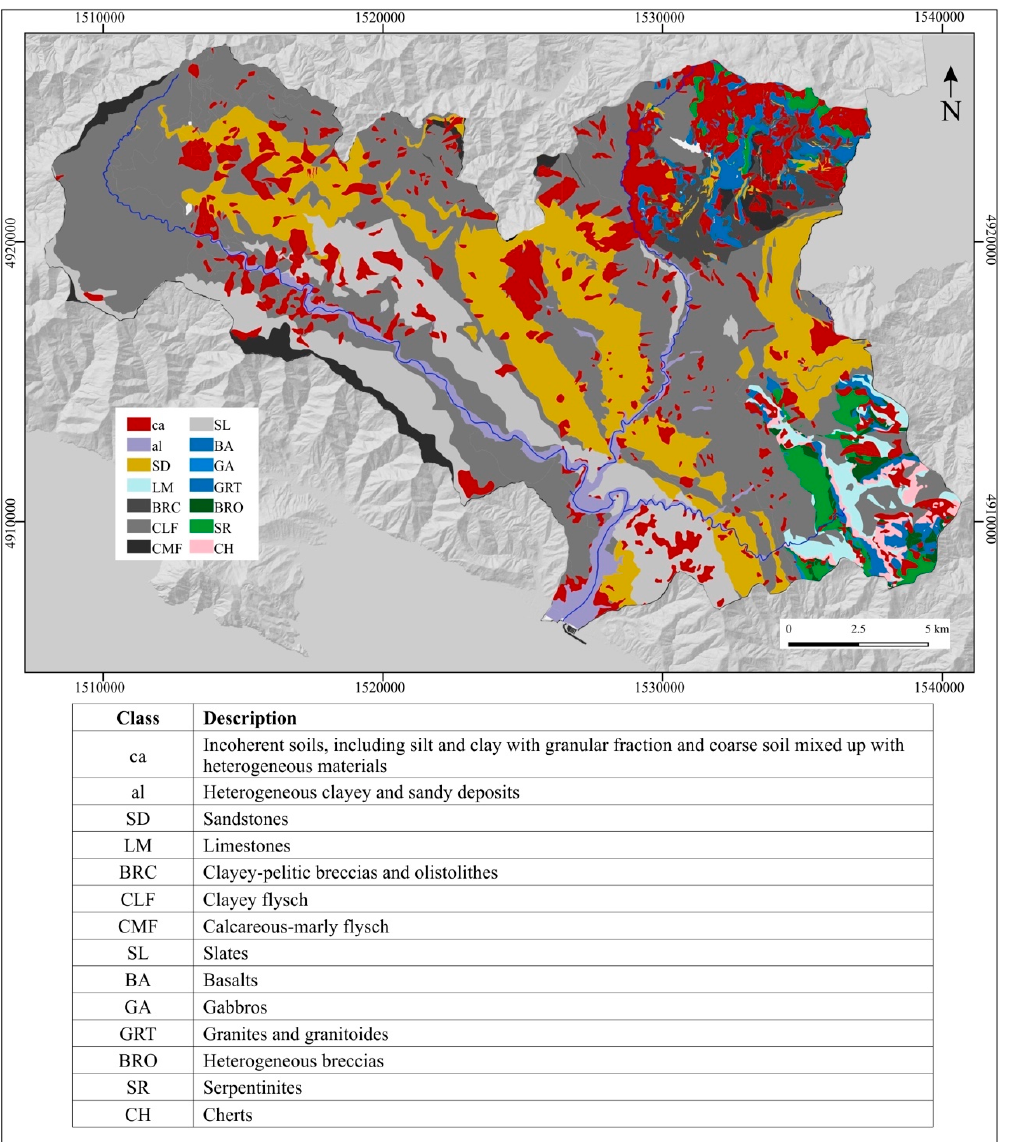
Figure 3. Litho-technical map of the Entella River basin.